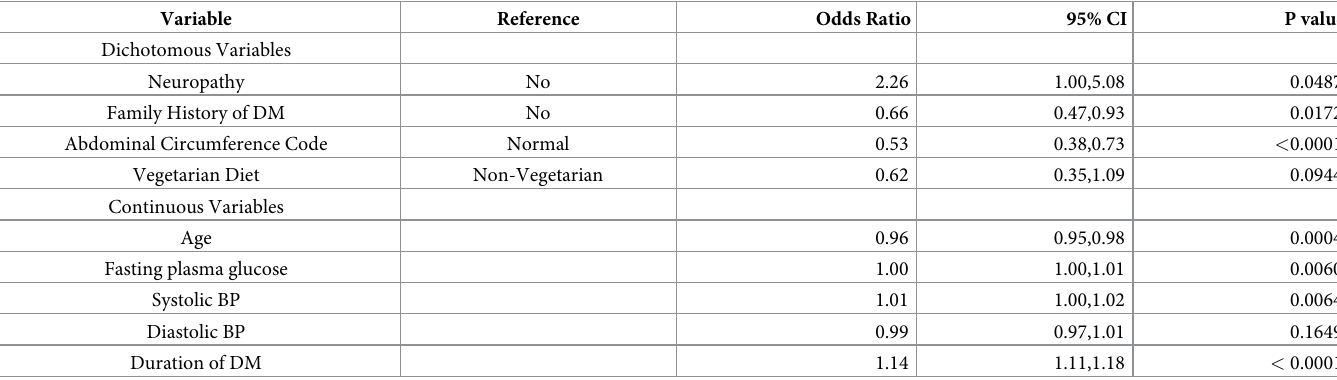
Table 3. Multivariate analysis using only variables selected empirically by stepwise regression–Association with